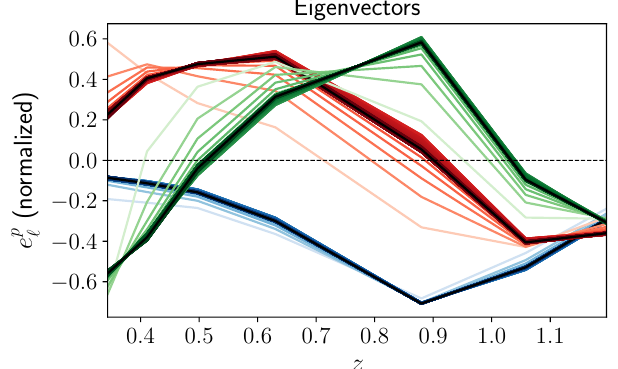
Figure 10. We show the first three eigenvectors of the KL trans- form as a function of the redshift bin. Blue lines represent the first eigenvector, red lines the second and green line the third one. Different shades of the same colour indicate the eigenvector for different (cid:96) ’s (lightest colour refers to (cid:96) = 2 and increases towards darker shades with ∆ (cid:96) = 10).